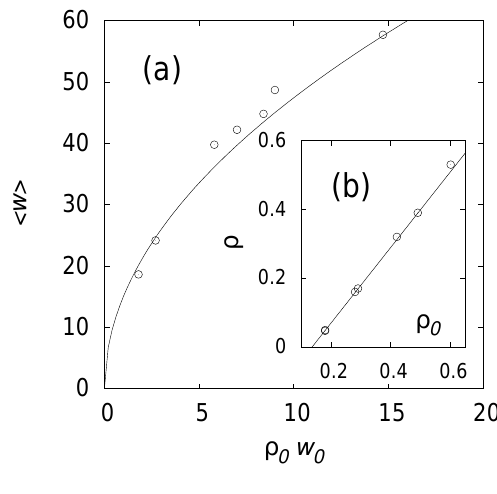
Fig. 15. (a) The average width h w i as a function of the product between the incoming dune density ρ 0 and the width w 0 of the in- coming dunes at the boundary. (b) The final stationary density ρ of the dune field as function of the initial density ρ 0 at the boundary. Note that below ρ c (black circle) no dune field formation can be